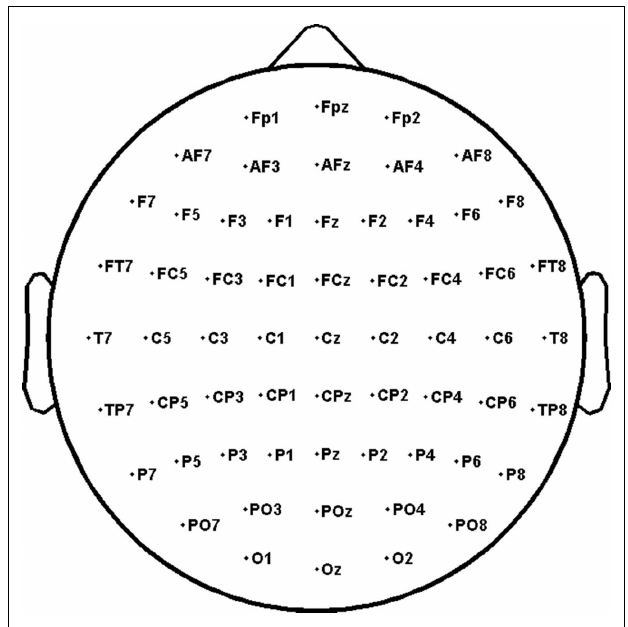
FIGURE 1 | Electrode montage schematic (standard 10–10 system) used in the ERP analysis.